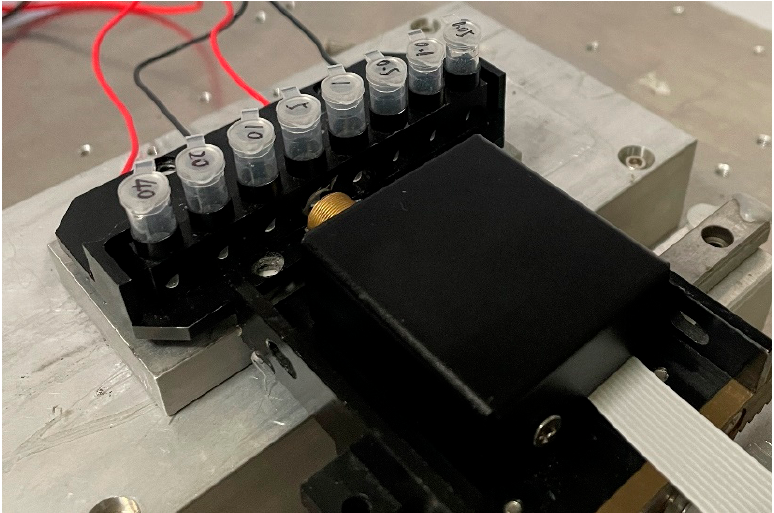
Figure 4. Photo of the test platform based on the fluorescence detector in this paper.